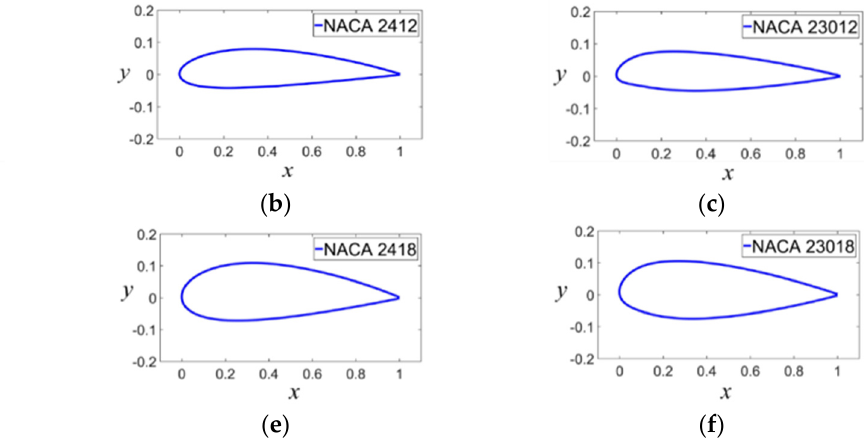
Figure 9. Geometric sketch of the six different airfoil profiles: NACA0012 ( a ), NACA2412 ( b ), NACA23012 ( c ), NACA0018 ( d ), NACA2418 ( e ), and NACA23018 ( f ). The dimensionless hydrodynamic coefficients of the rhomboid wing of AUG at the angle of attack of − 4 ◦ ≤ α ≤ 25 ◦ were respectively calculated when the inflow velocity was set as 1.0 m/s. Figure 10 shows the simulation results of the AUG lift coefficient, drag coefficient, and lift–drag ratio with different angles of attack.